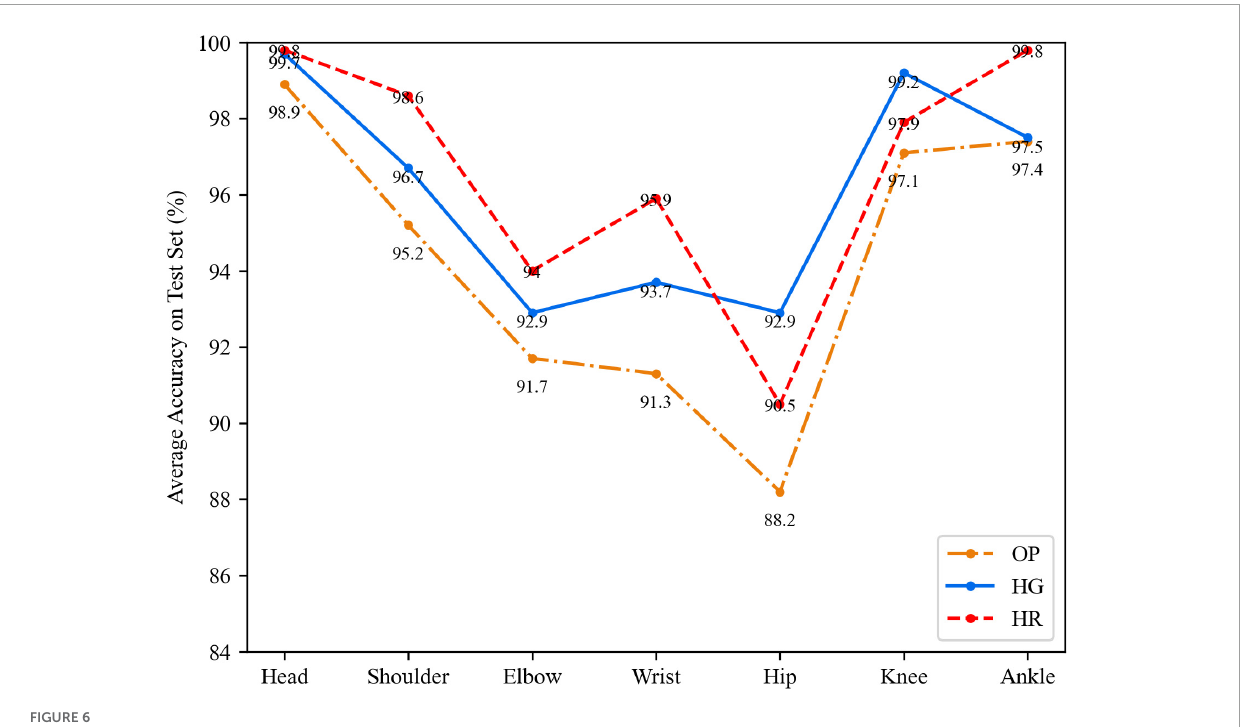
FIGURE6 The average accuracy on each kind of key point in a 2D